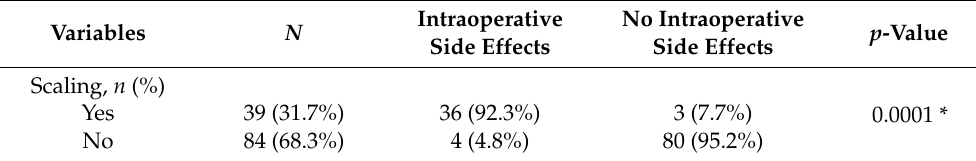
Table 2. Statistical significance of intraoperative side effects in relation to dental treatment.